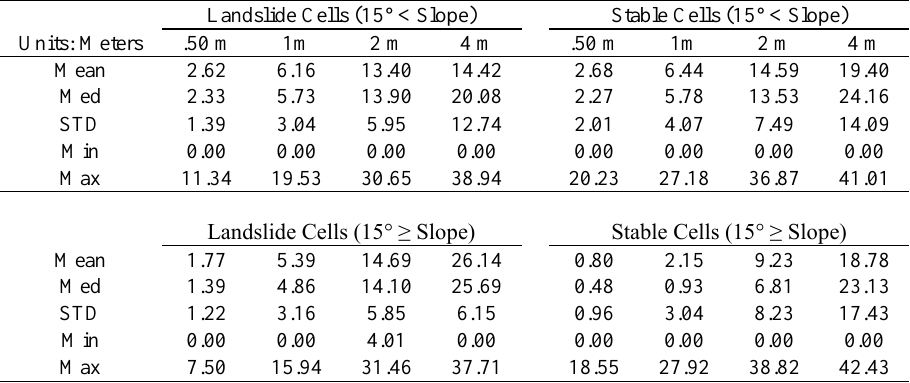
Table 7. Statistics of Sobel operator surface feature.